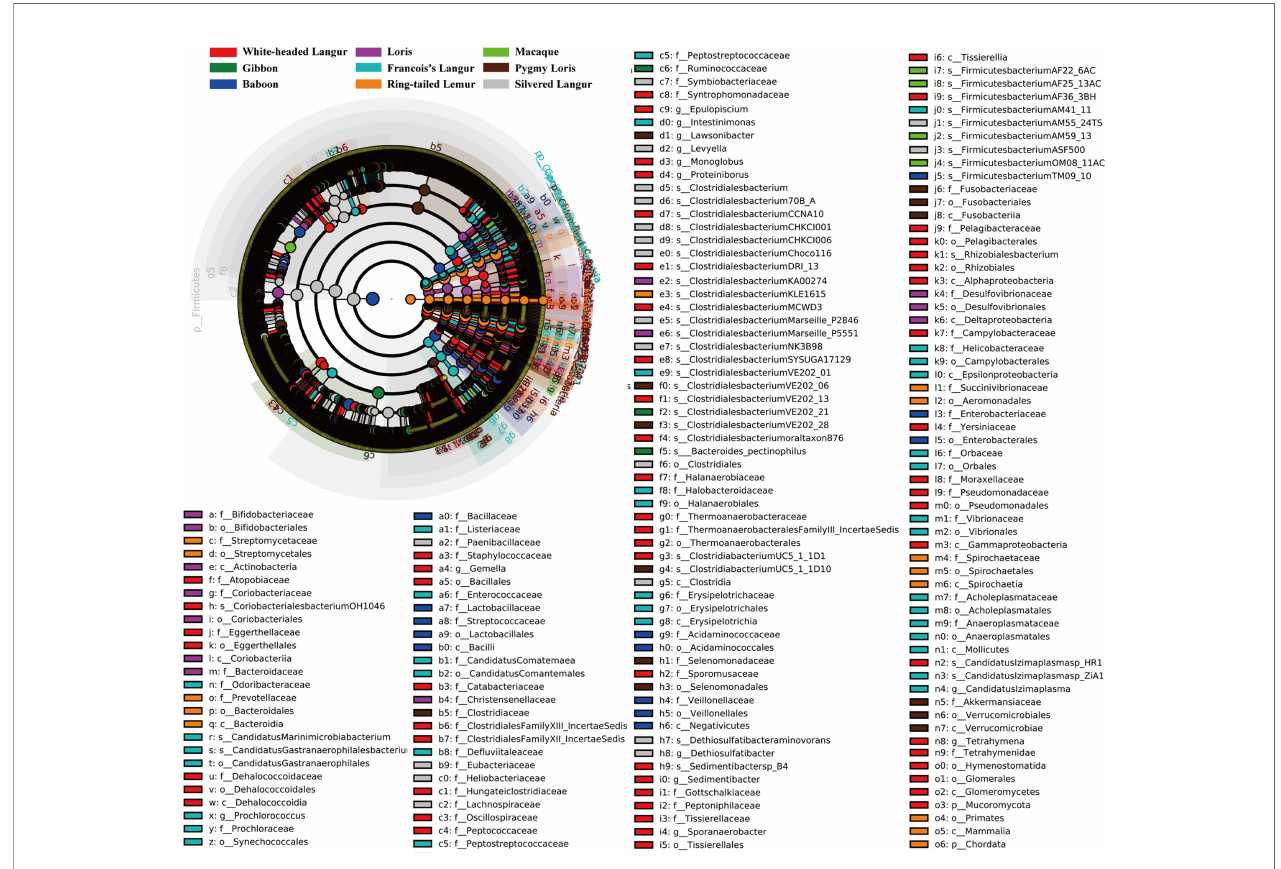
FIGURE 5 | Cladogram of the signi fi cantly different biomarkers in all